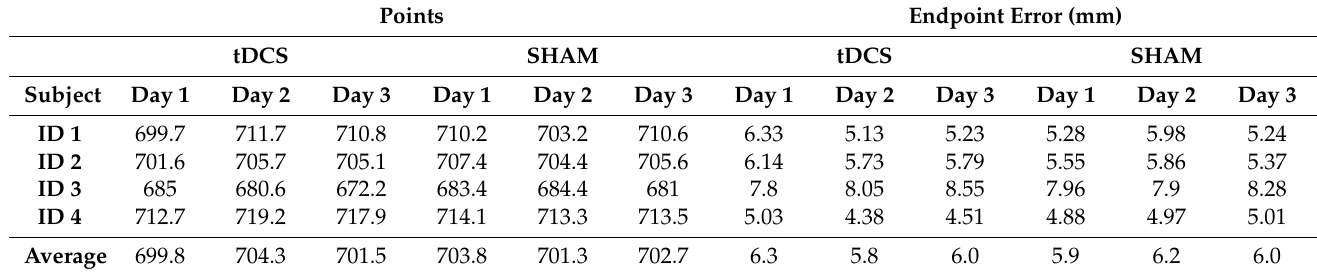
Table 1. Points and endpoint error for each practice day in the DLPFC-tDCS and SHAM